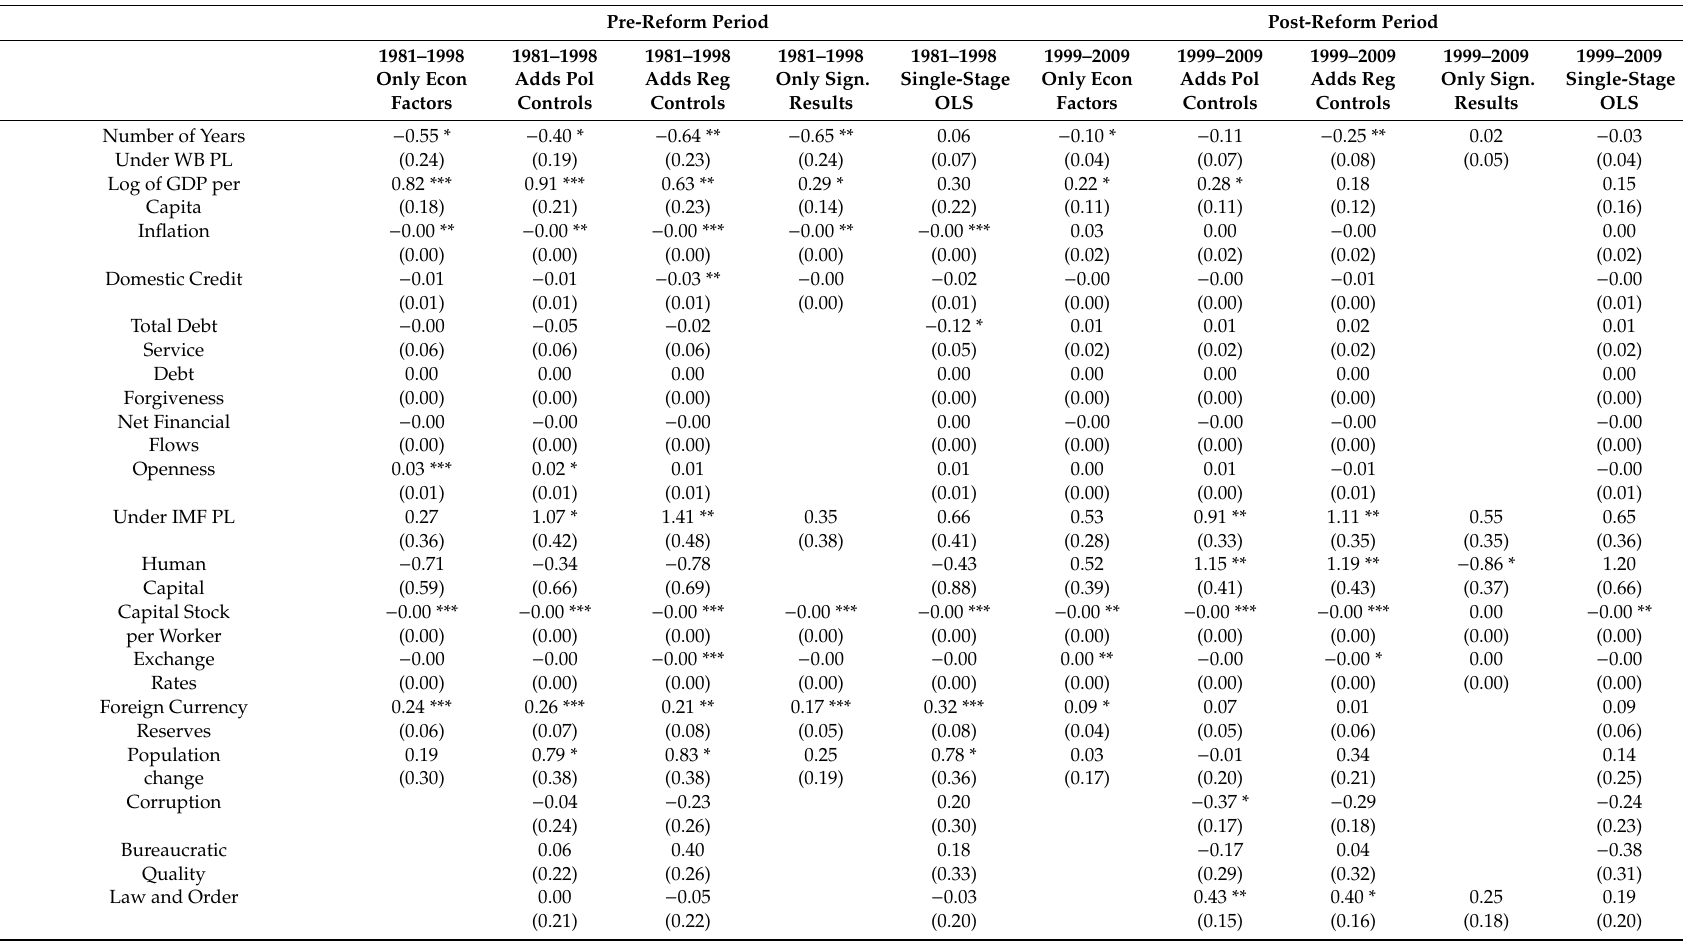
Table A3. Two-Stage and Single-Stage Least Squares: World Bank Program Lending and Its E ff ects on Economic Growth, Pre-and Post-Reform Periods, All Developing Countries with Regional and Annual Fixed E ff